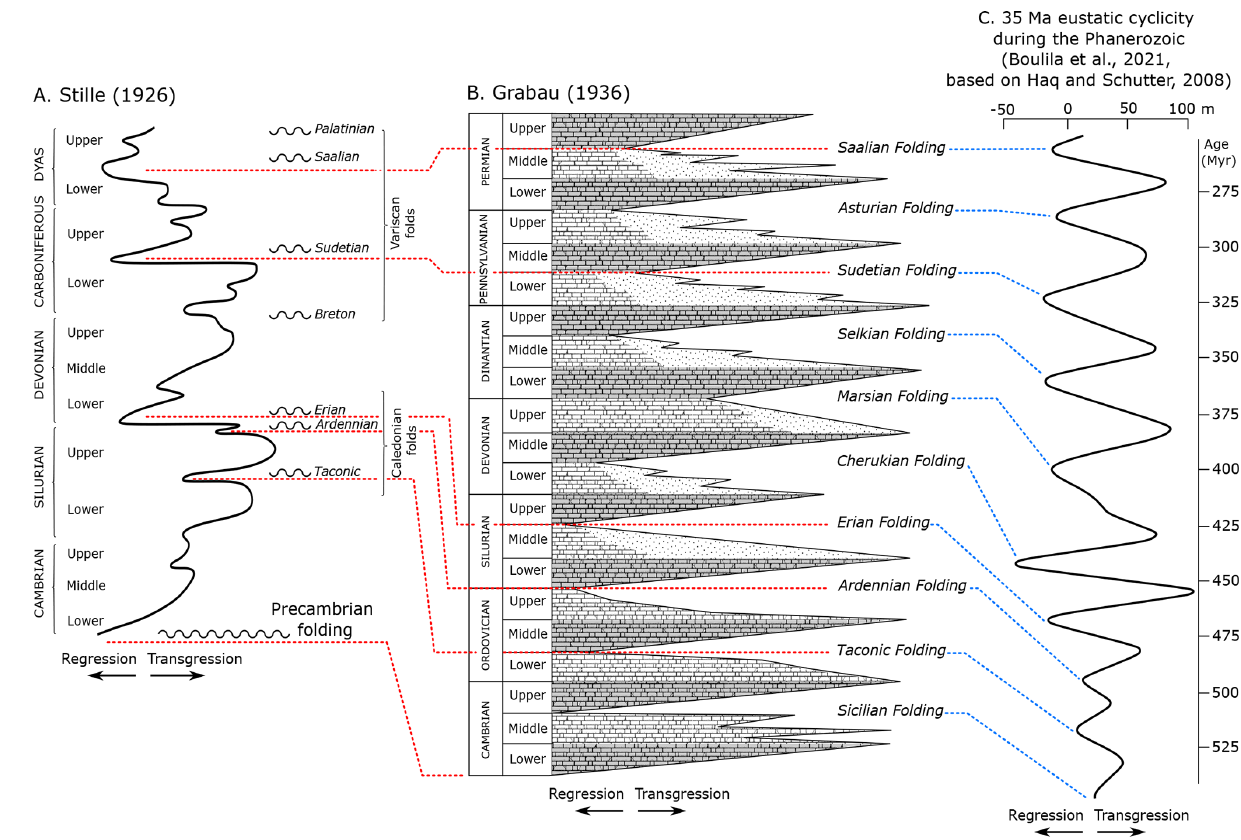
Figure 8. Global sea-level curves. (a) Modified from Stille (1926) and (b) modified from Grabau (1936). Both indicate the main orogenetic periods associated with rapid marine regressions. The red lines indicate the same events identified by Stille (1926) and Grabau (1936). (c) Paleozoic eustatic cycles of approximately 35Myr (determined by bandpass filtering of data presented by Haq and Schutter, 2008) and potential correlation (blue lines) with equivalent cycles of Grabau (1936) (modified from Boulila et al.,